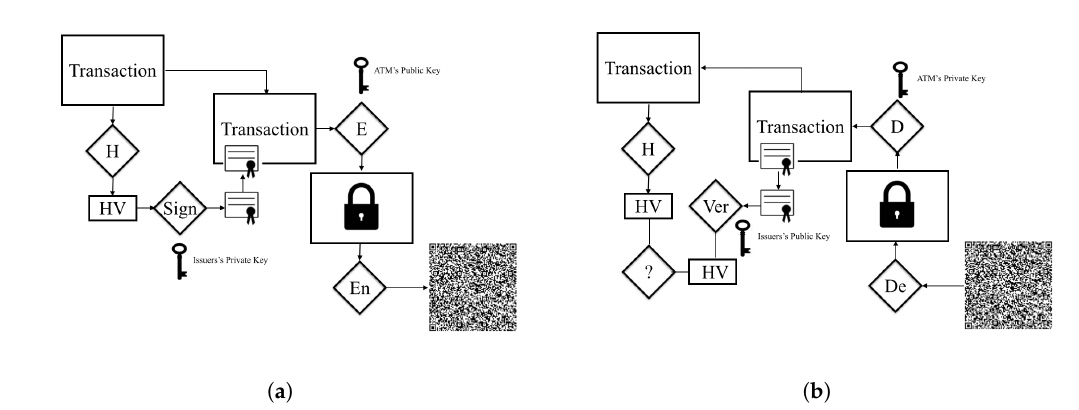
Figure 7. Simplified examples of generating and verifying QuickCash Offline